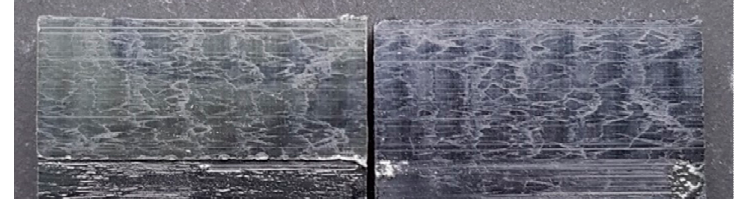
Figure 19. Fracture surface of the degreased specimen subjected to fatigue test.